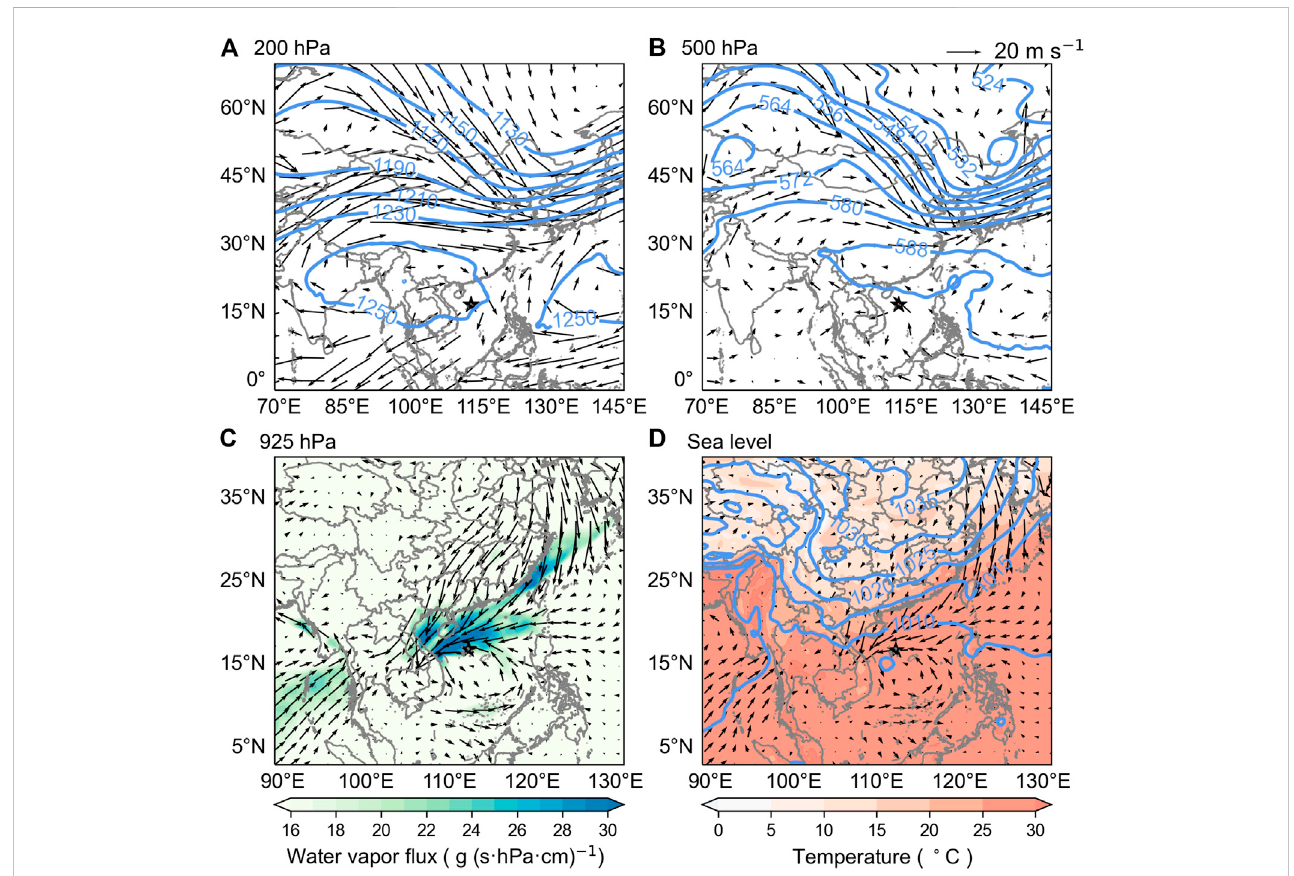
FIGURE 3 Large-scale circulation at 17:00 on 16 October 2021. (A) Geopotential height (blue contours, units: dagpm) and wind fi eld at 200 hPa; (B) Geopotential height(bluecontours,units:dagpm)andwind fi eldat500 hPa; (C) Watervapor fl ux[shading,units:g(s · hPa · cm) − 1 ]andwind fi eldat925 hPa; (D) Meansealevel pressure (blue contours, units: hPa), 2 m temperature (shading, units: ° C) and 10 m wind fi eld. The black star represents Sansha meteorological station (the same below).